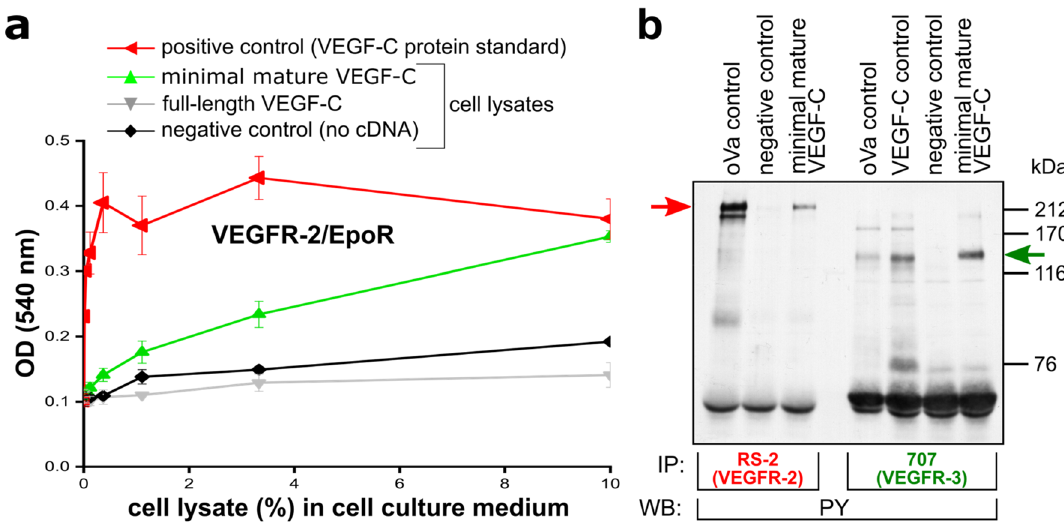
Figure 4. MBP-tagged minimal mature VEGF-C expressed in the cytoplasm of E. coli Origami (DE3) can activate both VEGFR-2 and VEGFR-3. Minimal mature MBP-VEGF-C expressed in Origami (DE3) ( a ) promotes the survival of Ba/F3 cells stably transfected with a VEGFR-2/EpoR chimeric receptor, (n = 2) Error bars indicate ± SD, and ( b ) stimulates the phosphorylation of VEGFR-2 and VEGFR-3 expressed by PAE cells without the need of refolding. PY denotes phosphorylated tyrosine. The major phosphorylated receptor bands are indicated by arrows.